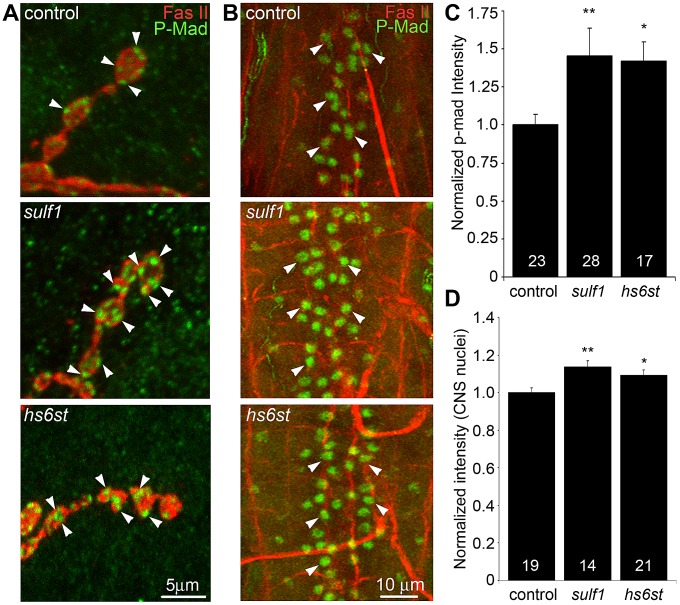
Loss of sulf1 and hs6st causes differential effects on BMP signaling.(A) Representative NMJ synaptic boutons on muscle 6 in segment A3 from control (w1118), sulf1 and hs6st nulls, labeled with neural marker anti-Fasciclin II (FasII, red) and for phosphorylated Mothers against decapentaplegic (P-Mad; green) activated downstream of Gbb signaling. Arrows indicate representative P-Mad punctae in the indicated genotypes. (B) Representative ventral nerve cord (VNC) midlines from the same 3 genotypes, labeled with anti-FasII (red) and P-Mad (green). Labeled motor neuron nuclei are indicated by arrows. Quantification of the mean fluorescent intensity level of P-Mad labeling normalized to FasII co-label at the NMJ synapse (C) and in motor neuron nuclei (D), normalized to genetic control. Sample sizes are ≥14 animals per indicated genotypes. Statistically significant differences calculated using the Mann-Whitney test for non-parametric data, * p<0.05, ** p<0.01. Error bars indicate S.E.M.